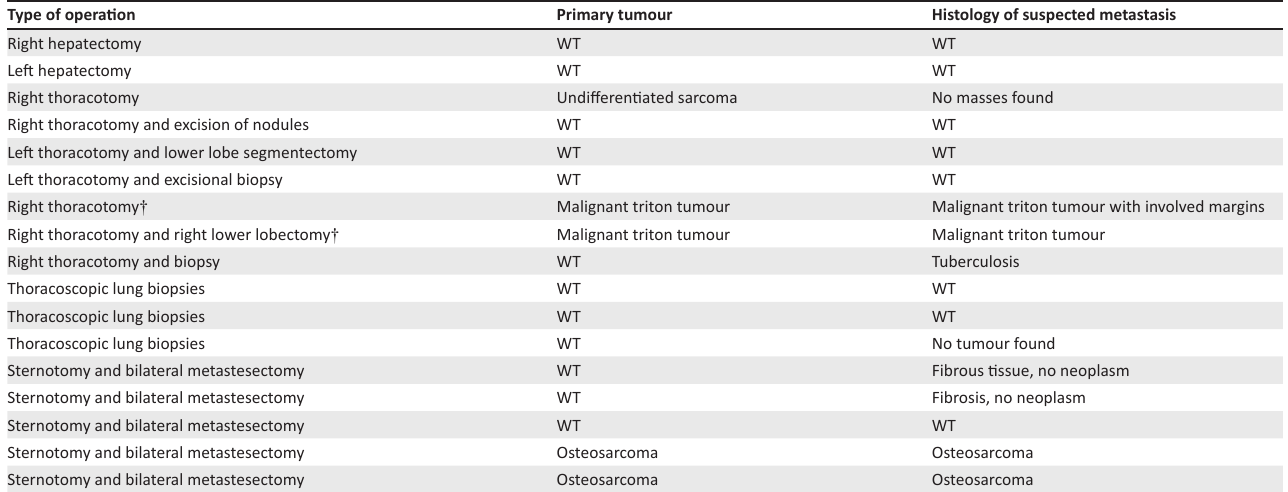
TABLE 4: Operations for metastatic disease.